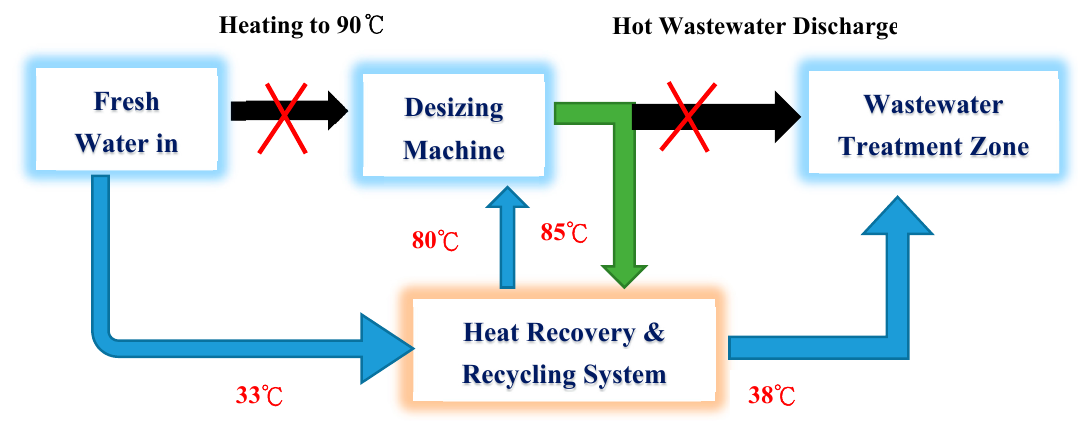
Figure 6. Heat recovery & recycling system in dyeing factory.